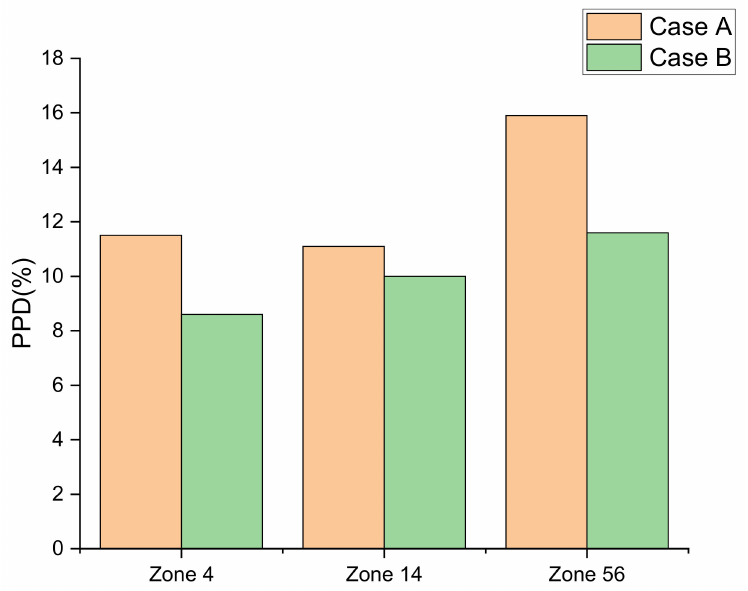
Figure 23. Comparison of the average PPD in July for zones 4, 14 and 56 in case A (no low-E film) and case B (with low-E film).